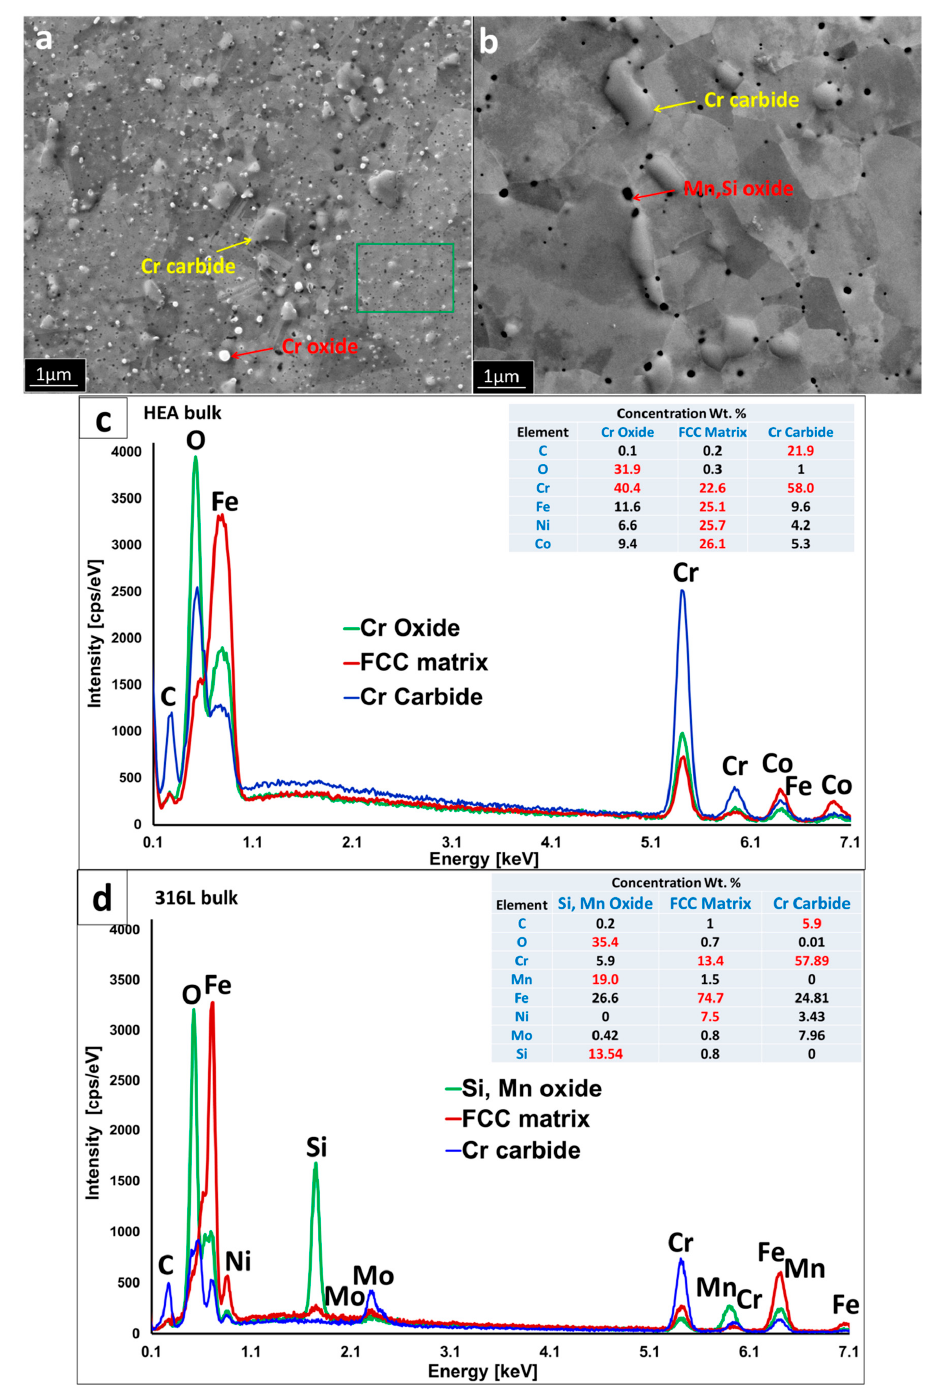
Figure 8. Representative microstructures of the bulk materials prepared from powders milled in Ar atmosphere for 30 h, taken with SEM in secondary electrons mode; ( a ) HEA; ( b ) 316L steel; ( c ) EDS analysis of representative particles in HEA; and ( d ) EDS analysis of representative particles in 316 L steel. The microstructures are composed from FCC matrix grains, oxide particles with varying chemistry and size, and larger chromium carbide particles. It should be noted that due to the insensitivity of EDS to light elements, the exact quantities of C and O elements presented in tables are only for informative